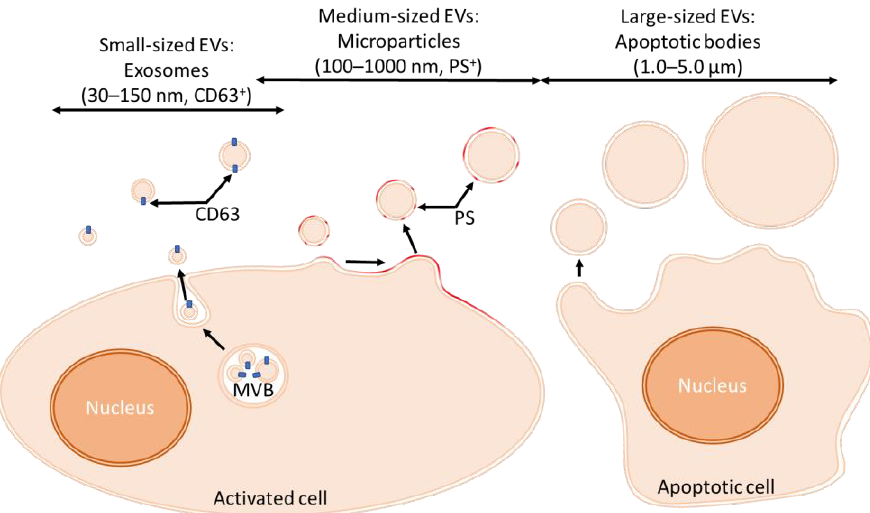
Figure 1. Biogenesis of EVs. Exosomes are produced following the fusion of multivesicular bodies (MVB) with plasma membrane. Common exosomal markers are CD63, CD9, CD81, and flottilin. Microparticle production results from intracellular Ca 2+ concentration increase. These medium-sized EVs expose phosphatidylserine (PS). Apoptotic bodies are produced during apoptosis and are the larger type of EVs.